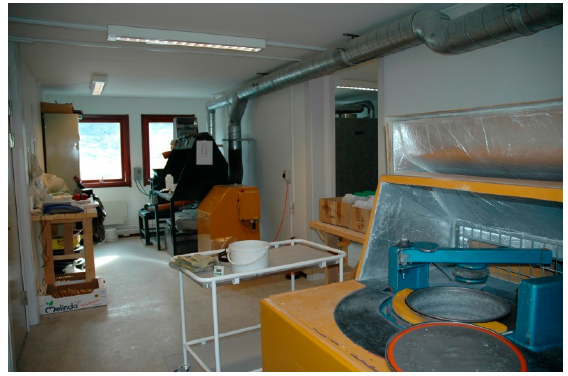
Figure 10. Mine laboratory with the LM5 pulveriser in the foreground.